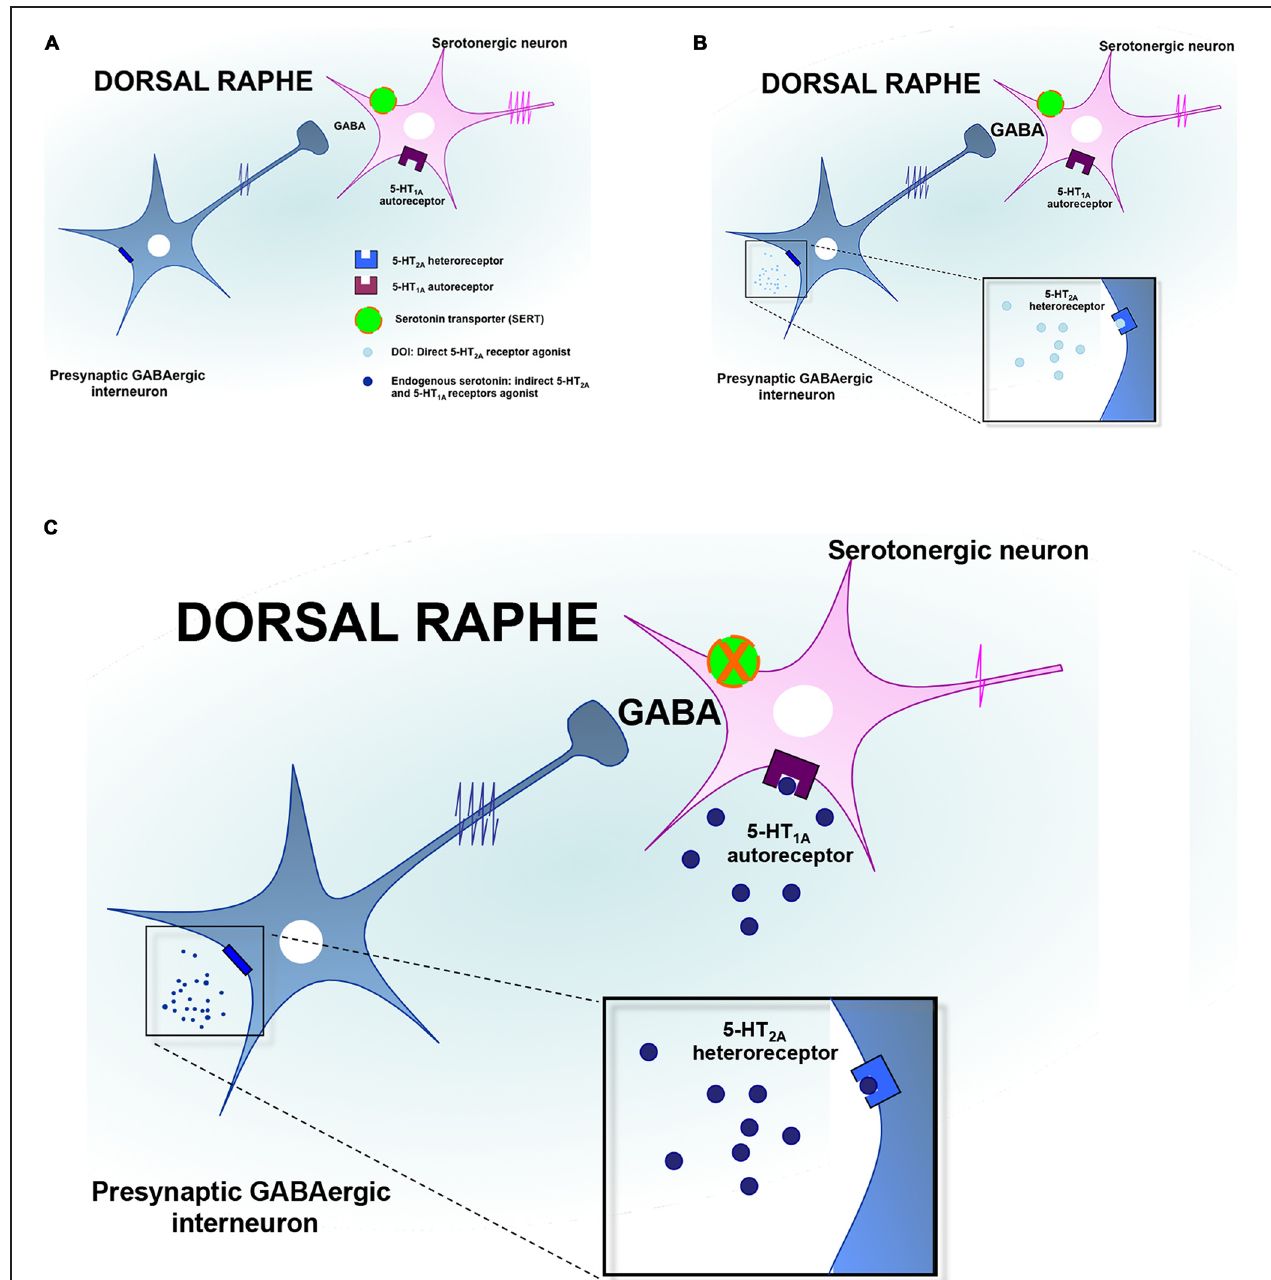
FIGURE 2 | Regulation of serotonin neuronal activity by the 5-HT 2A receptors in the dorsal raphe. (A) The dorsal raphe nucleus (DRN) contains GABAergic interneurons expressing the 5-HT 2A receptors (5-HT 2A -Rs) and which project on serotonergic neurons cell bodies to regulate their firing activity. (B) In response to the activation of 5-HT 2A -Rs by preferential agonists such as DOI, the neuronal activity of GABAergic